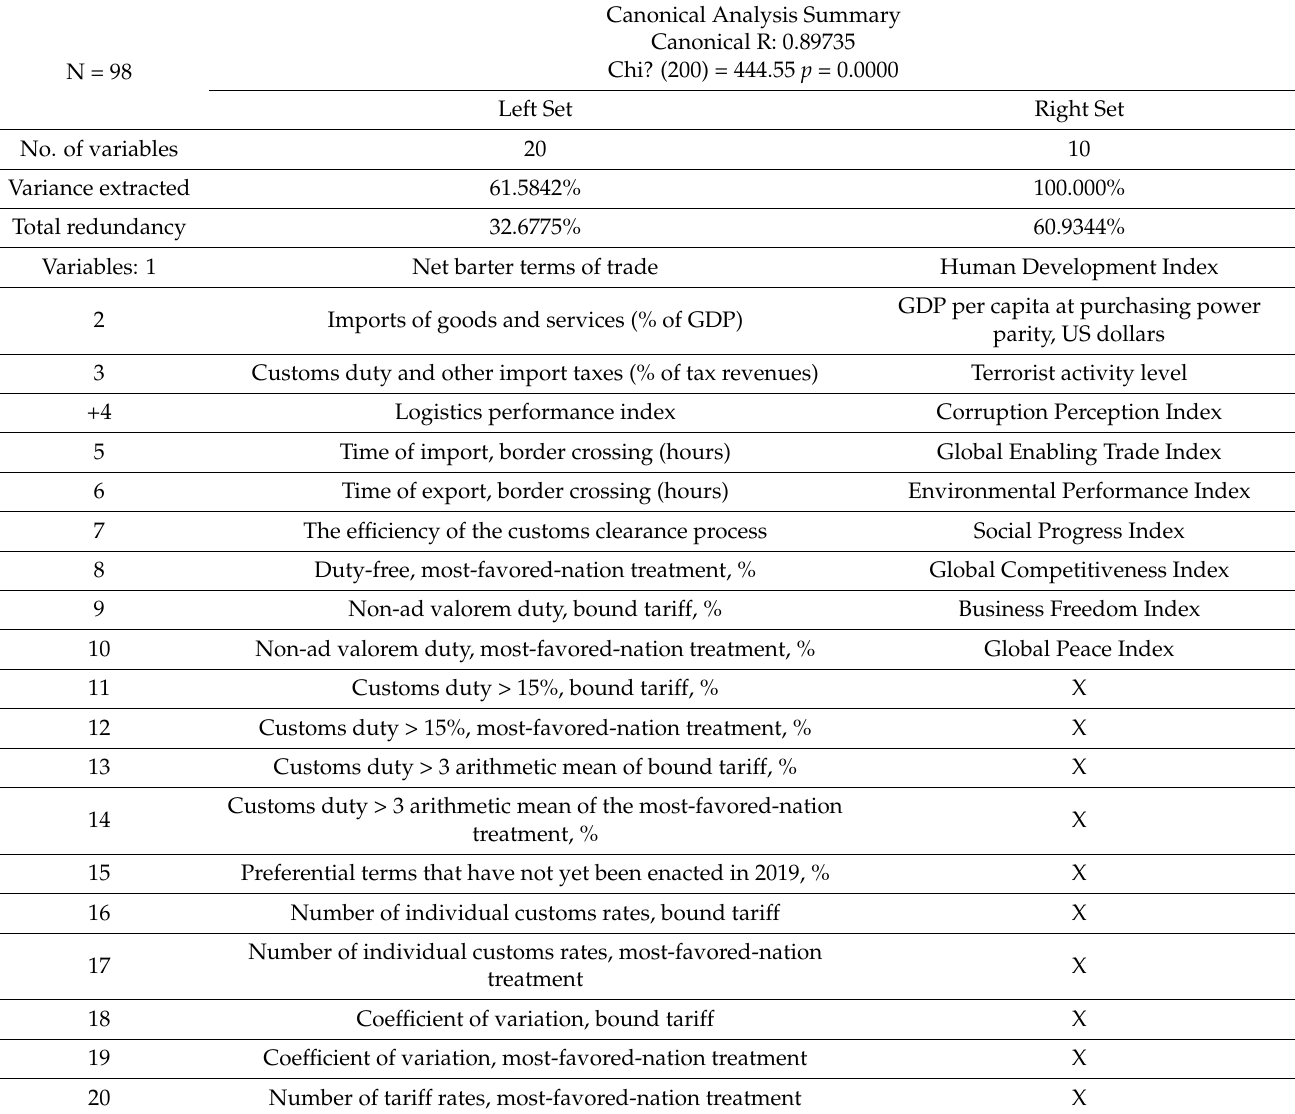
Table A2. The results of the canonical correlation analysis of the dependence of the customs space and sustainable development.